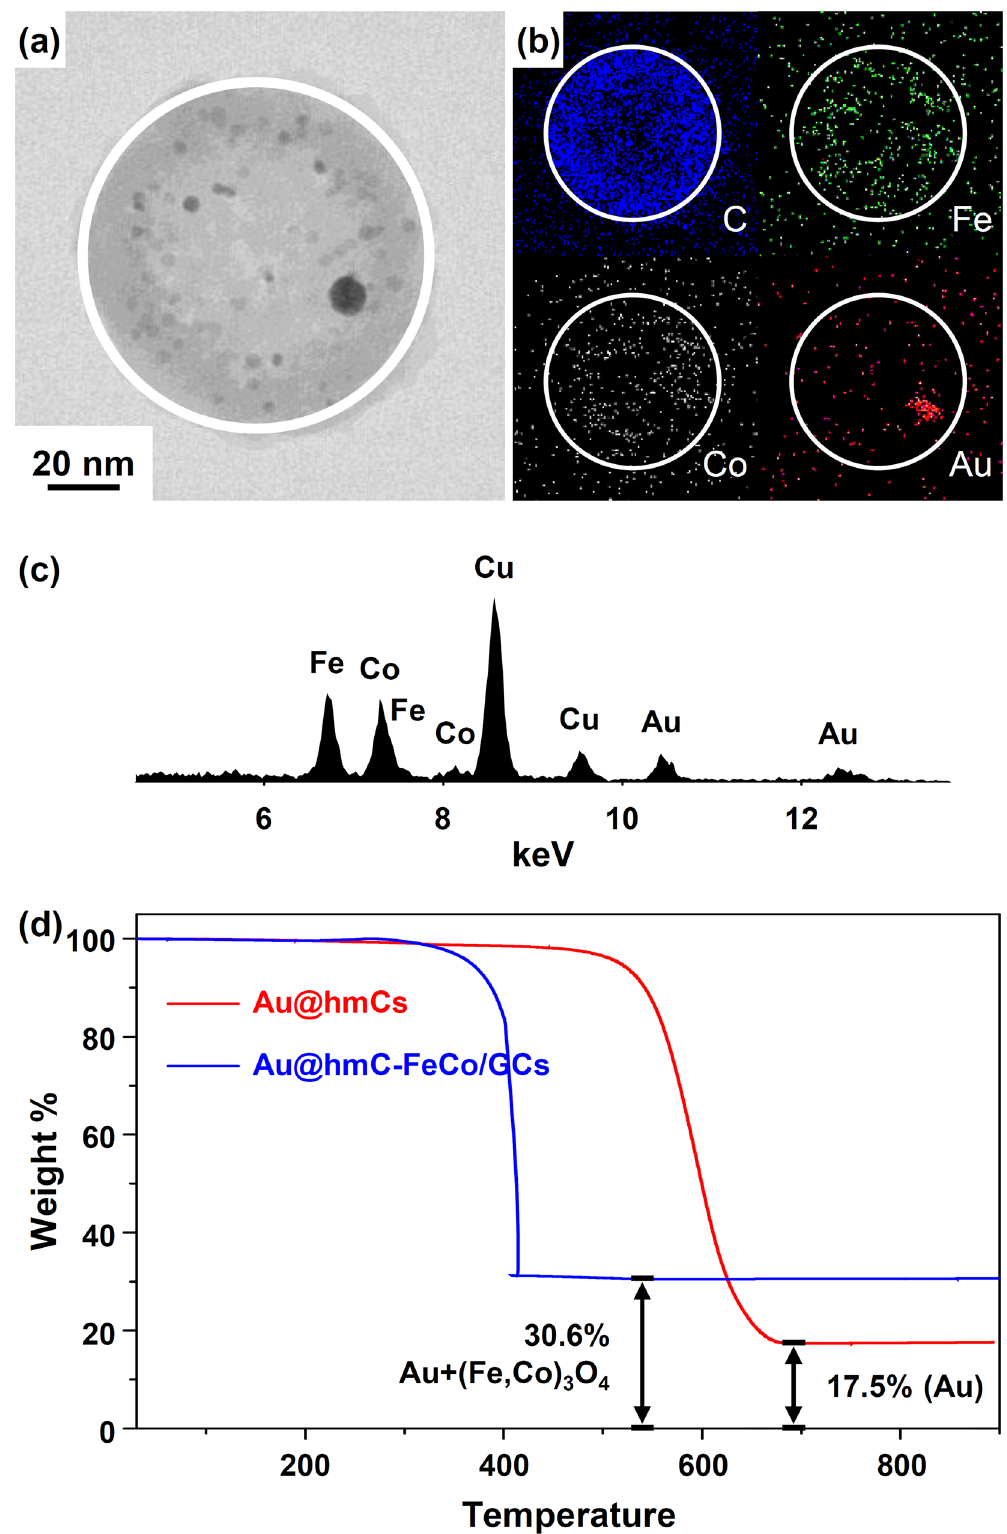
Figure 3. ( a ) STEM and ( b ) STEM-EDX elemental mapping (blue = carbon, green = Fe, white = Co, and red = Au) images, and ( c ) EDX spectrum of Au@hmC-FeCo/GCs. Copper is from the TEM grids. ( d ) TGA profiles for Au@hmCs and